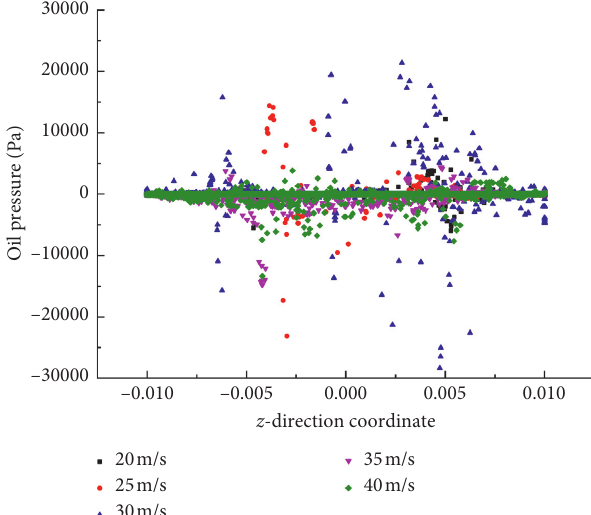
Figure 10: Oil pressure distribution along the tooth width direction.